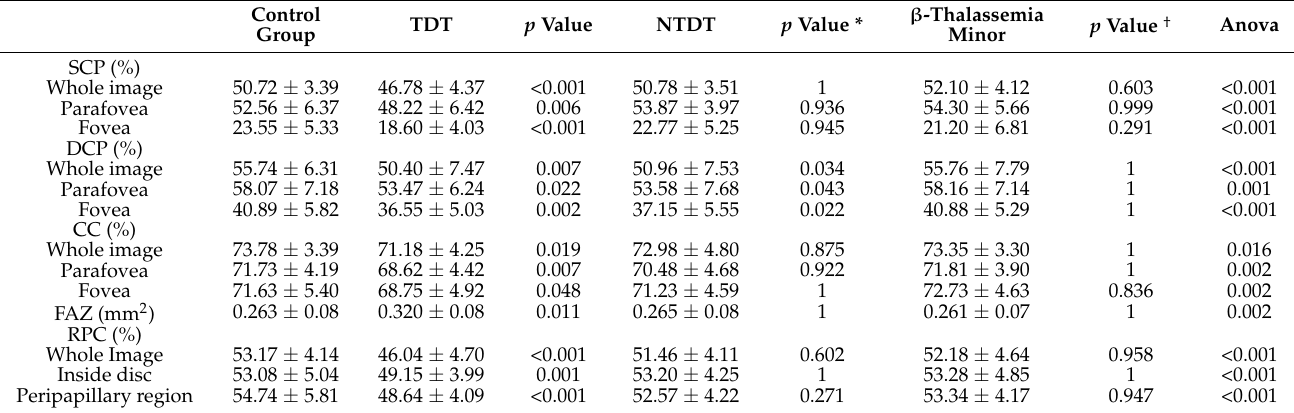
Table 3. Differences in OCT angiography parameters among the controls and β -thalassemia